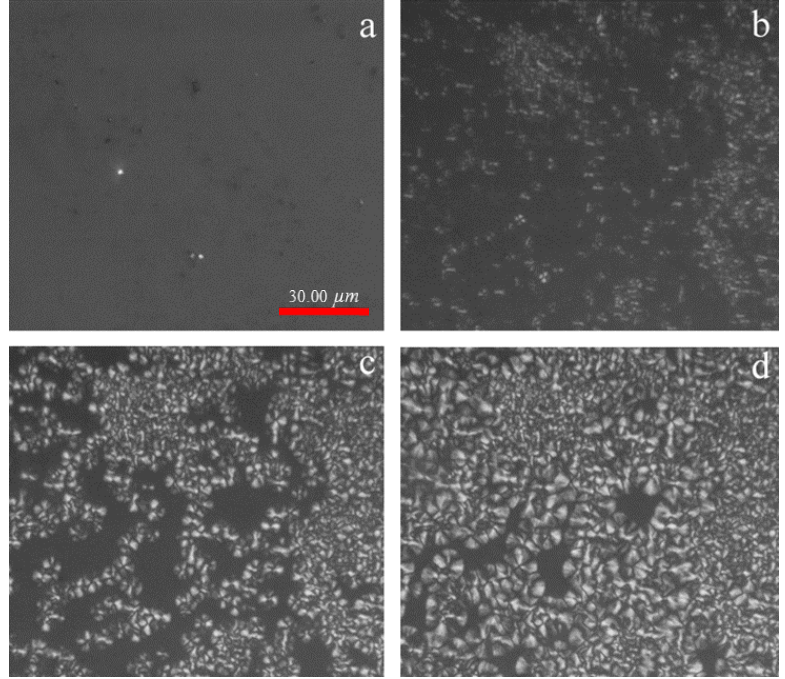
Figure 3. POM of PLLA crystallized isothermally at 100 °C ( a ) 0 min; ( b ) 3 min; ( c ) 6 min; ( d ) 9 min.